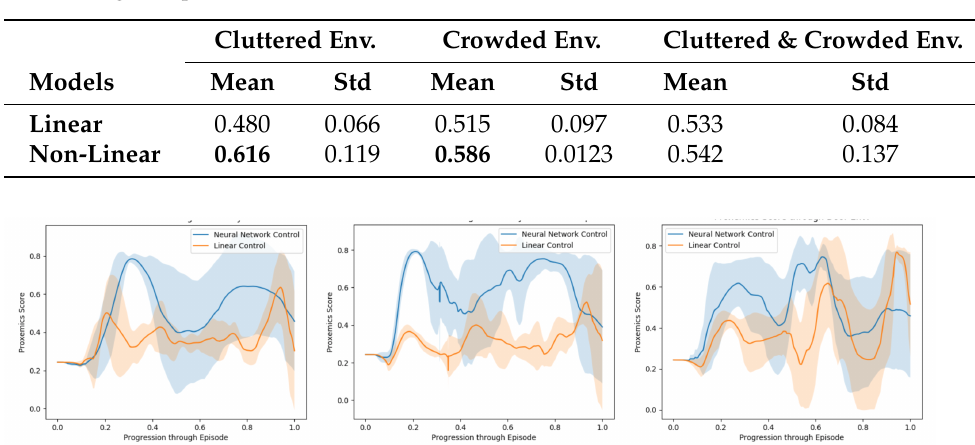
Figure 10. Evaluation Simulation. Evaluation of the model through proxemics social distances as presented in Section 6. From left to right: Cluttered environment, crowded scenarios and cluttered and crowded